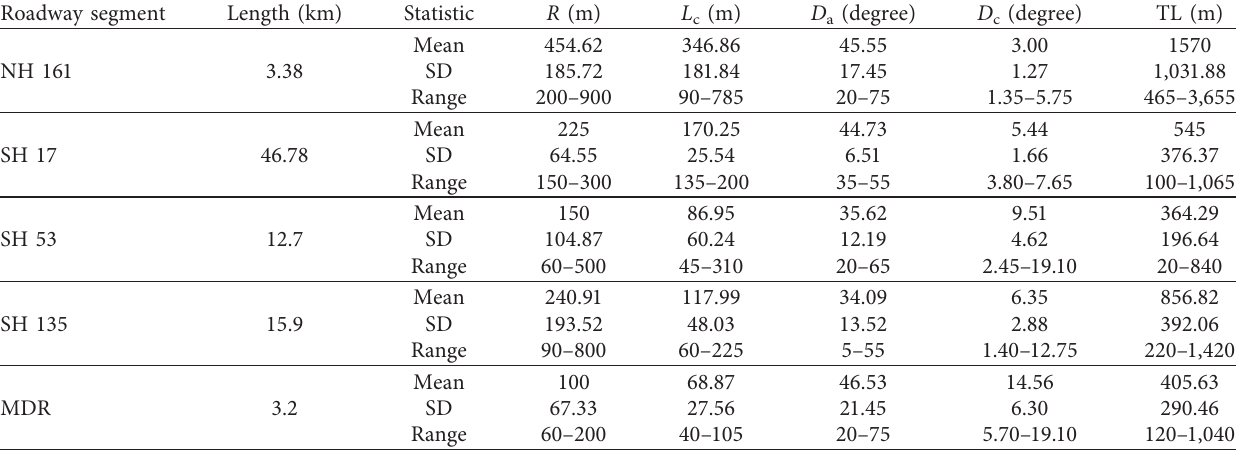
Table 4: Summary of road segment